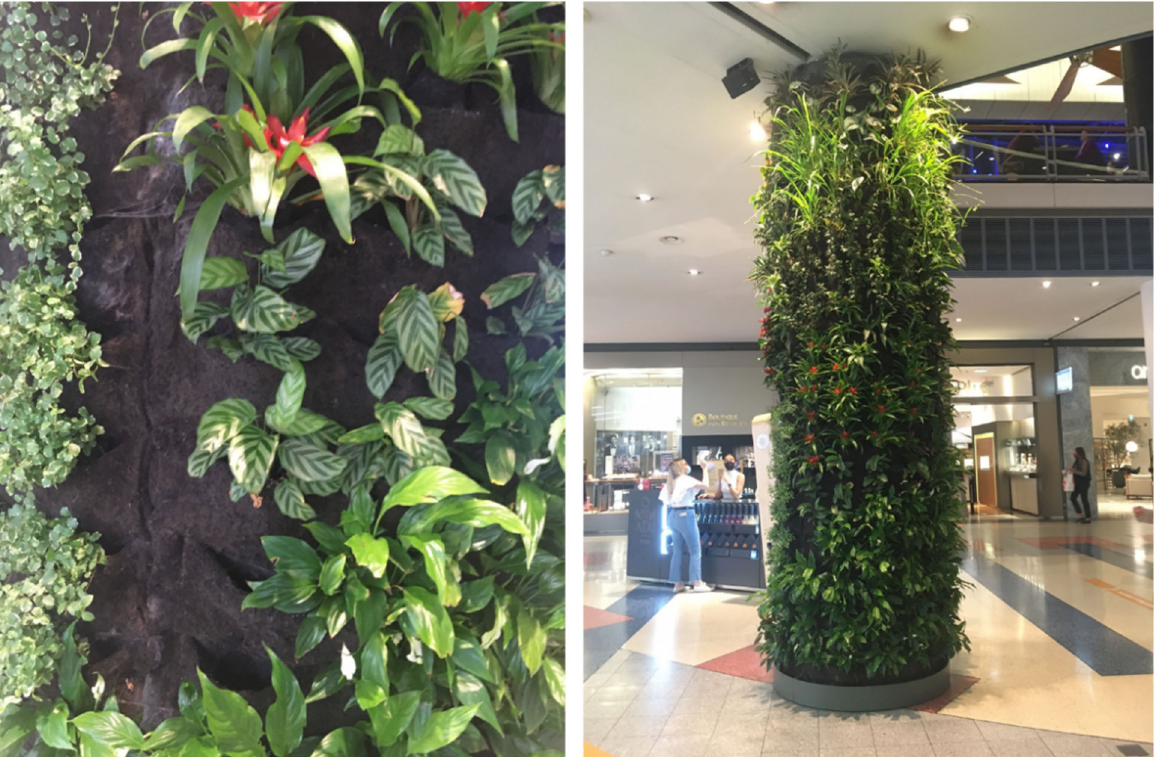
Figure 4. Continuous living wall system with felt pockets in a shopping center (Norteshopping, Matosinhos ‐ Portugal). Credits: Cristina Calheiros.